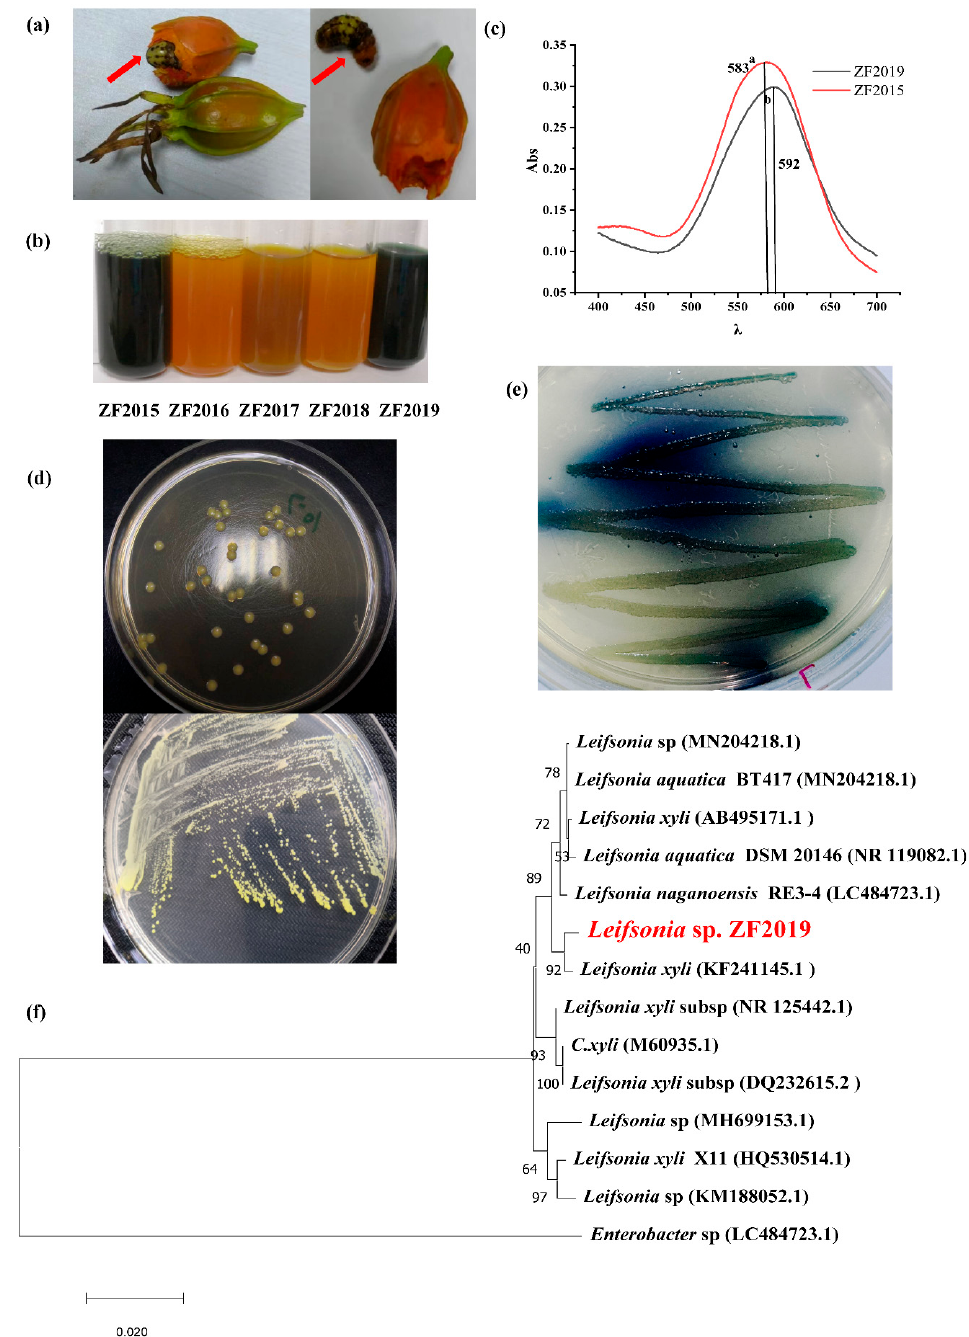
Figure 1. ( a ) Larvae of Artipe Eryx born inside gardenia fruits, leading to an empty fruit (nearly 30–40% empty fruit rate). ( b ) Color observation of GBP fermented by five strains from the larvae of Artipe Eryx , including ZF2015~2019 in LB liquid medium. ( c ) UV spectra of GBP fermented by ZF2015 and ZF2019. ( d ) Morphological observation of strain ZF2019. Different letters represent different maximum absorption wavelengths. ( e ) Observation after GBP production by strain ZF2019 on an agar plate. ( f ) Phylogenetic tree of Leifsonia sp. ZF2019 and corresponding strains based on 16S rRNA analysis. The phylogenetic tree was constructed by the neighbor-joining method, and the bootstrap value of the self-expanding test was marked on the branches 1000 times to evaluate the confidence of the phylogenetic tree and to determine the phylogenetic relationship and taxonomic status of the